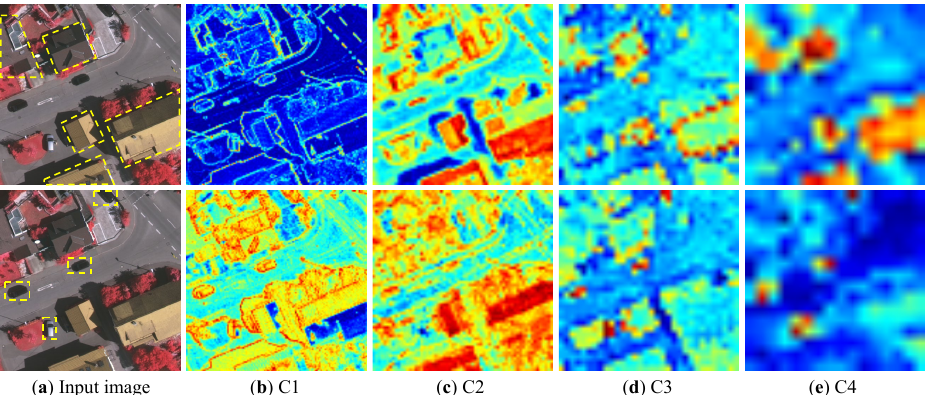
Figure 12. Visualization of C1, C2, C3, and C4 features of categories building ( top ) and car ( bottom ).